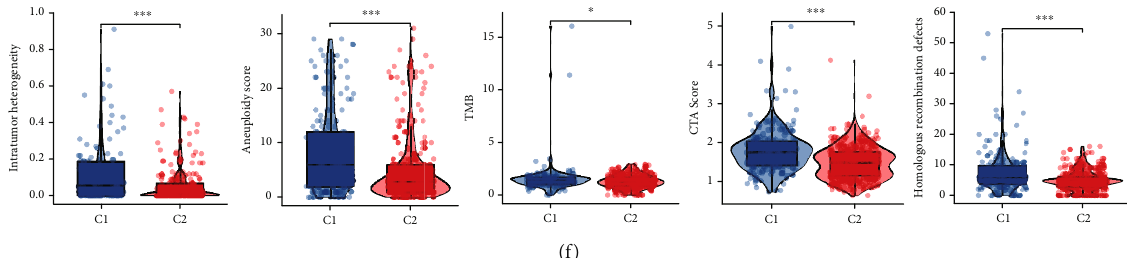
Figure 1: Consensus clustering and genomic instability analyses. The consensus clustering heat map (a), consensus CDF, and the relative change in area under the CDF curve (b) for the TCGA ccRCC cohort clustering. (c) The PCA plot depicts the sample distribution in the low dimension space divided by the clusters. (d) The Kaplan-Meier curve exhibited the time sequencing survival rate di ff erences between the clusters. (e) The heat maps exhibiting the gene copy number ampli fi cation and deletion in each site of the chromosomes in each cluster. (f) Comparison of the genomic instability-related indexes between the